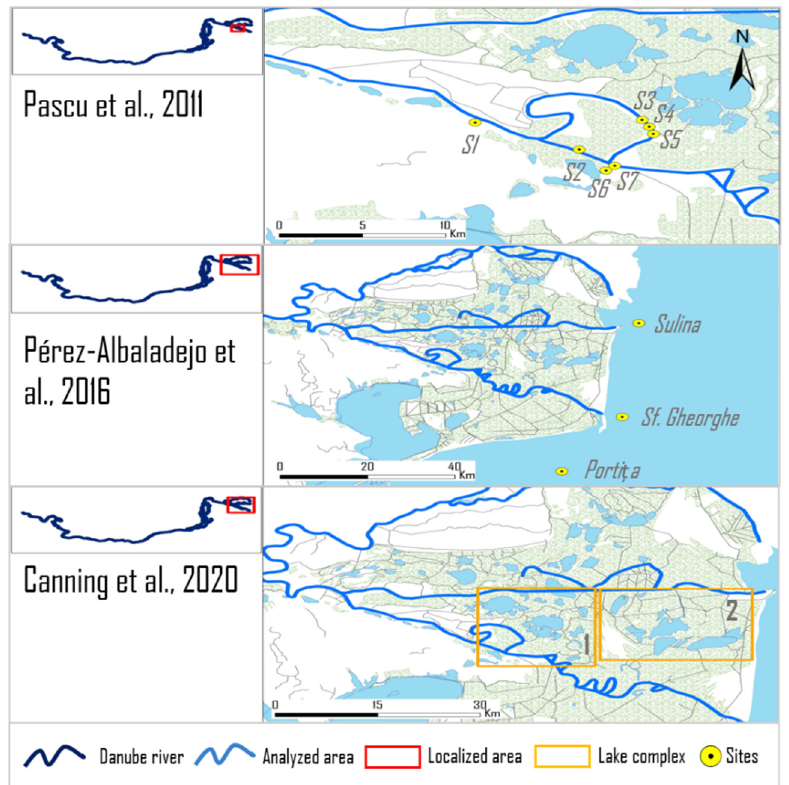
Figure 9. The sites and sections sampled and analyzed in specific sectors of Danube Delta. .[56,59,63]